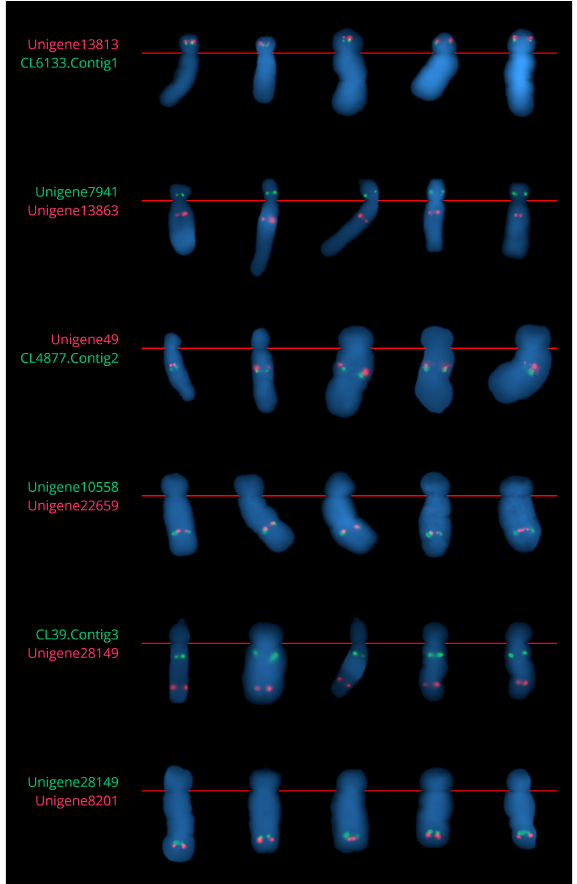
Figure 4. Extracted chromosome 6 of A. cepa from metaphases with selected